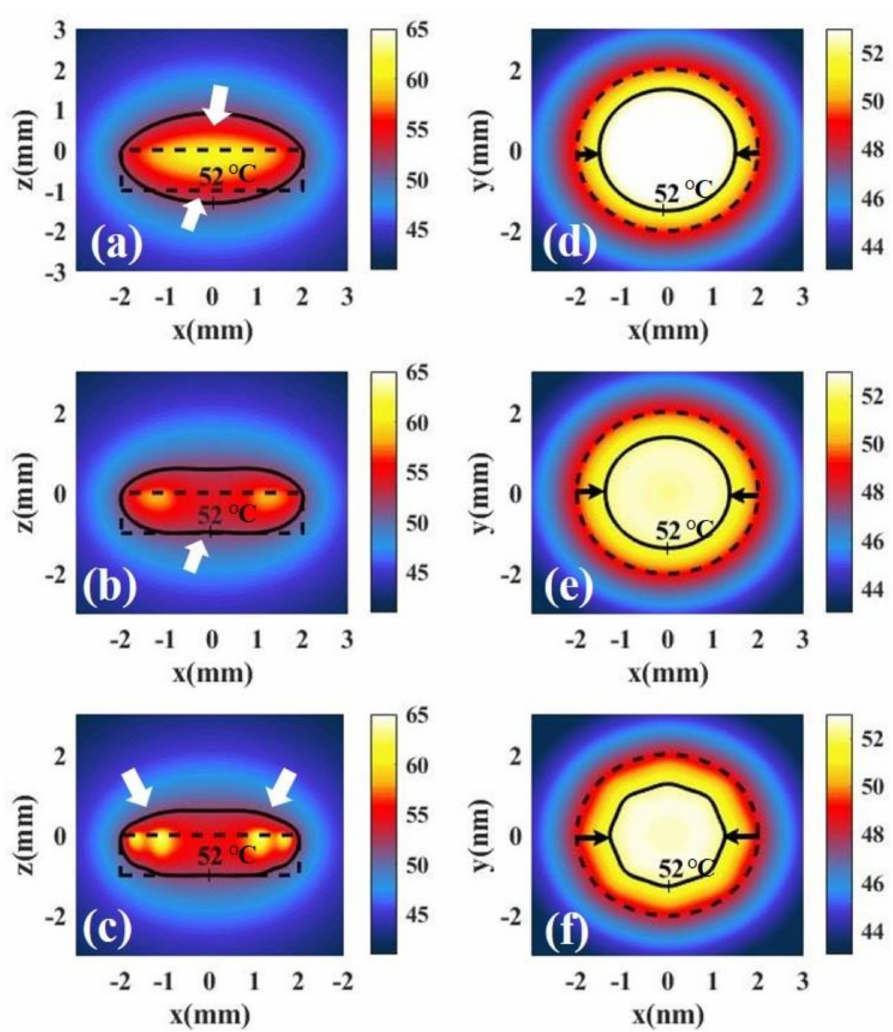
Figure 11. Temperature distributions of tumor tissue at the x–z plane and y = 0 irradiated by different irradiation shapes: ( a ) full-coverage light, ( b ) ring light, and ( c ) spot array light. Temperature distribution of tumor tissue at the x–y, z = 0.5 mm plane irradiated by different irradiation shapes: ( d ) full-coverage light, ( e ) ring light, and ( f ) spot array